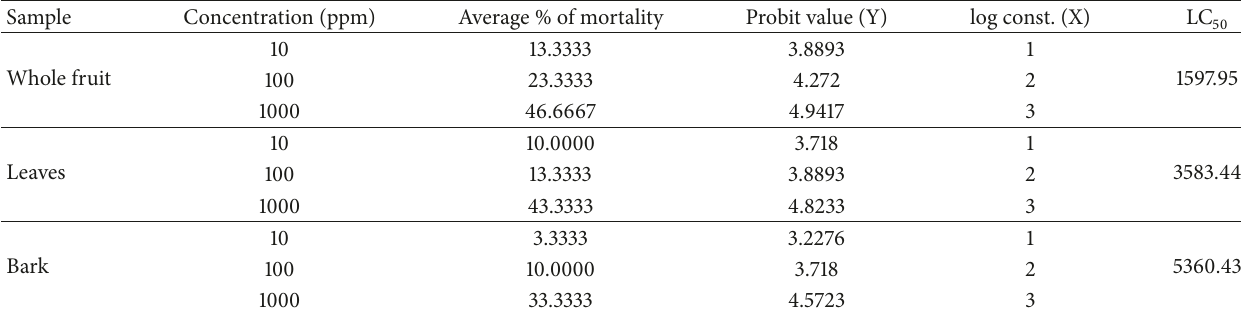
Table 3: Brine shrimp lethality test of L. alata